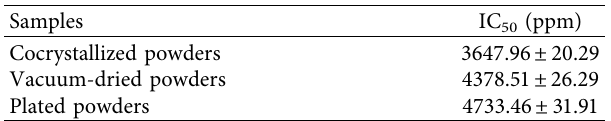
Table 1: Te antioxidant activity of moringa leaves extract powders.